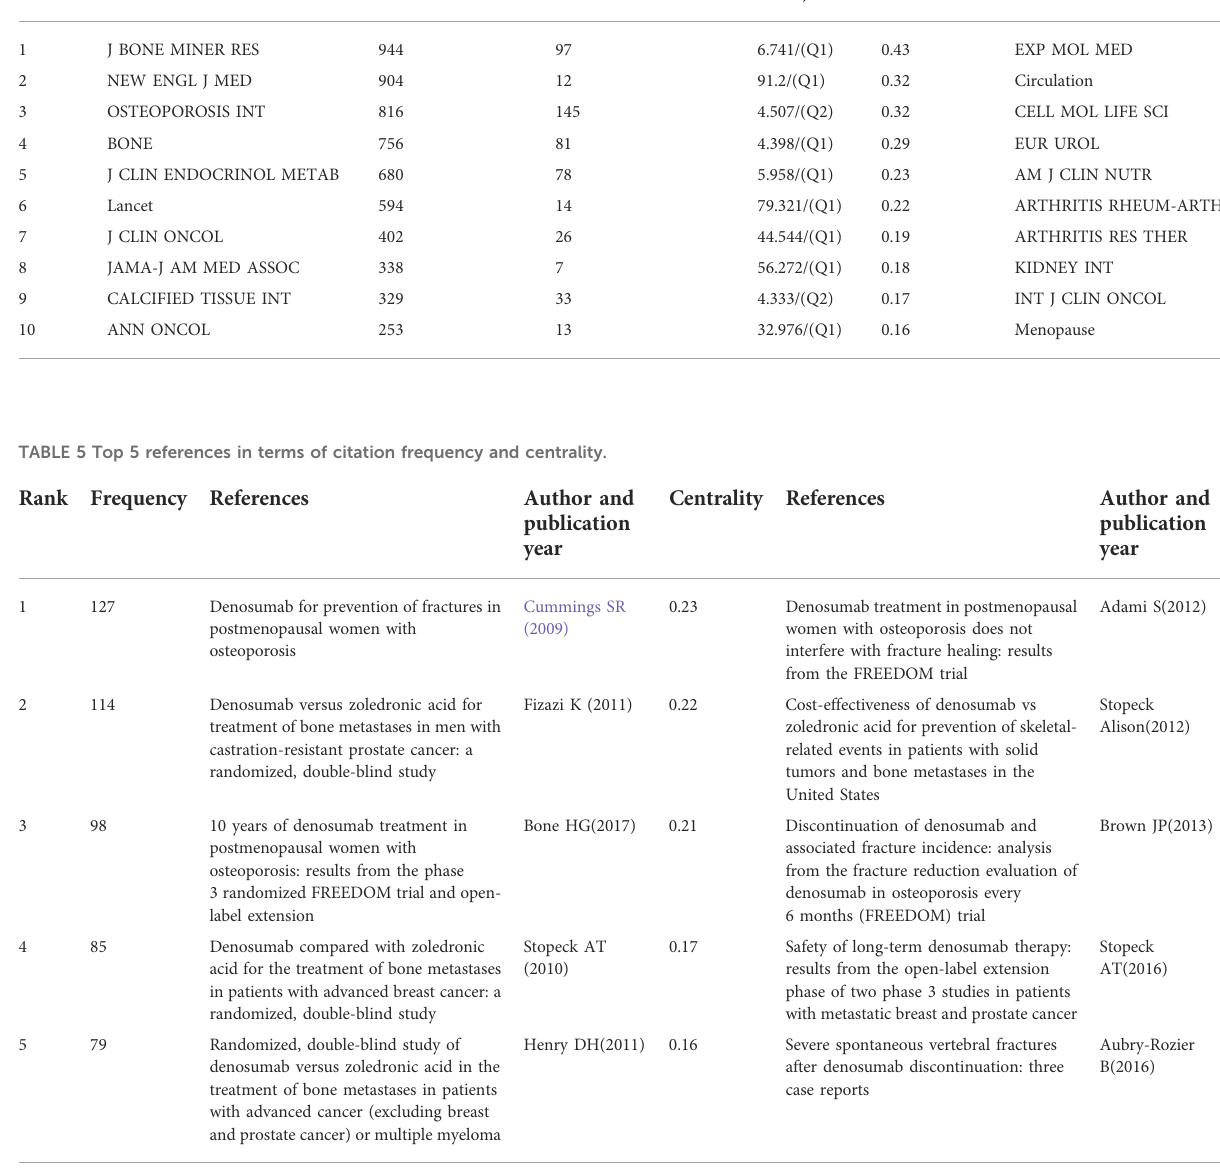
osteoporosis: results from the phase 3 randomized FREEDOM trial and open- Denosumab compared with zoledronic acid for the treatment of bone metastases in patients with advanced breast cancer: a randomized, double-blind